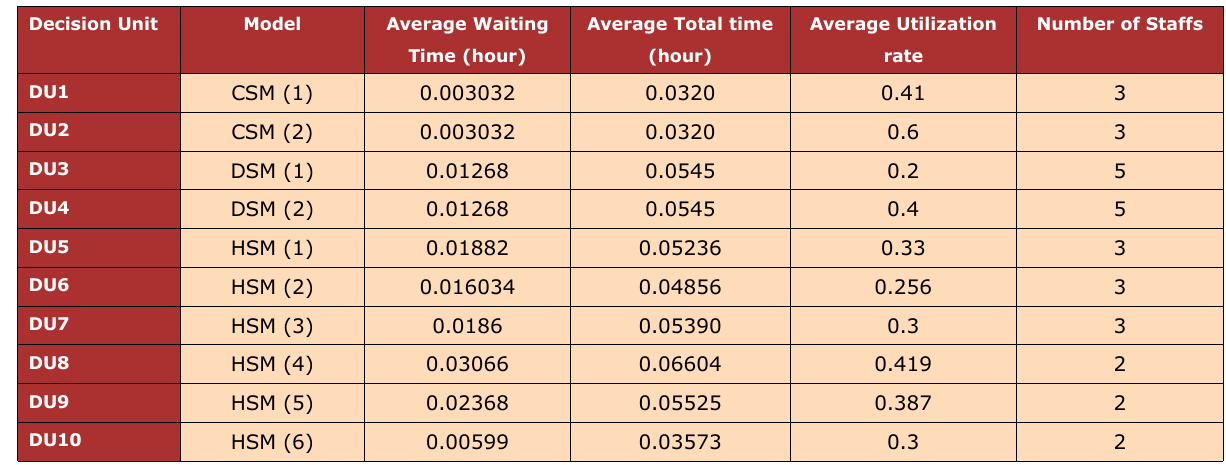
Table 5. Simulation outputs for the setting with medium interaction